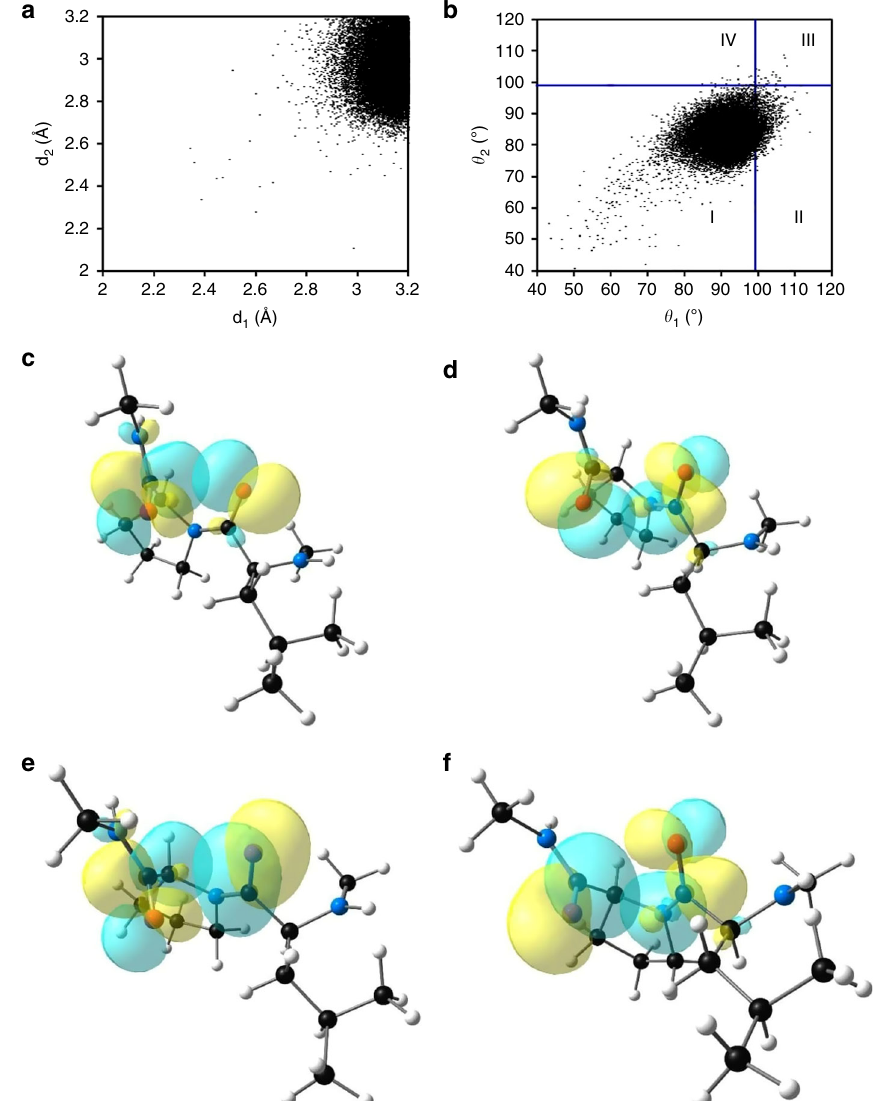
Fig. 4 X-ray crystallographic data and NBO overlap diagrams for amino acid pairs. a Plot showing the distribution of O ··· C distances (d 1 and d 2 ) in amino acid pairs in proteins having reciprocal C ═ O ··· C ═ O interactions. b Plot showing the distribution of ∠ O ··· C = O angles θ 1 and θ 2 in amino acid pairs in proteins having reciprocal C ═ O ··· C ═ O interactions. The vertical and horizontal blue lines are drawn at θ 1 = 99° and θ 2 = 99°, respectively. c NBO orbital overlap between oxygen lone pair ( n O ) of CO-I and π * C = O orbital of CO-II of Leu-Pro (141 – 142) [PDB: 2x5o]. d NBO orbital overlap between oxygen lone pair ( n O ) of CO-II and π * C = O orbital of CO-I of Leu-Pro (141 – 142) [PDB: 2 × 5o]. e NBO orbital overlap between the π orbital of C = O bond of CO-I and